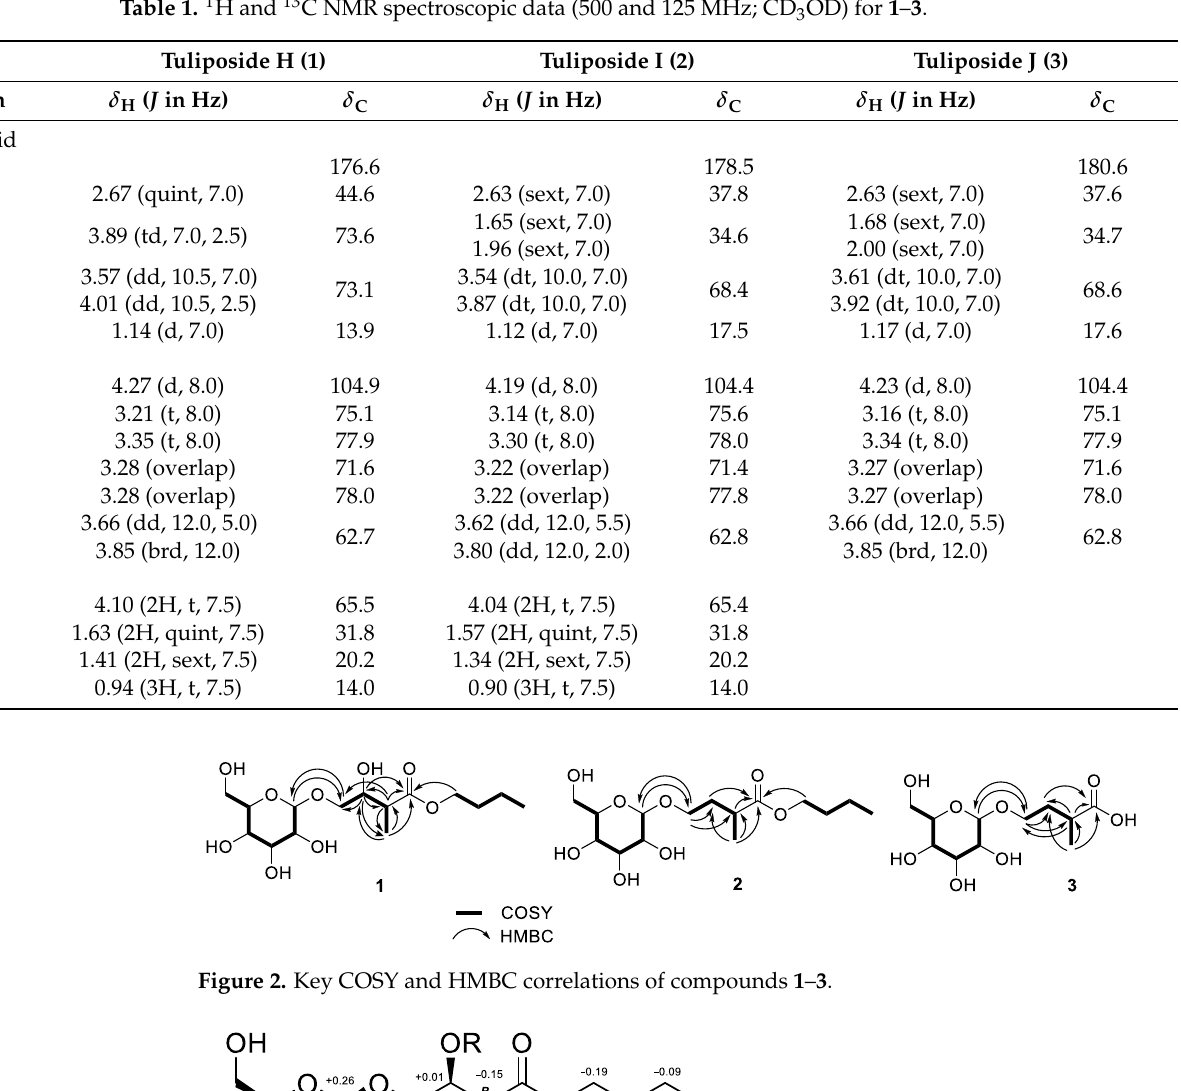
Table 1. 1 H and 13 C NMR spectroscopic data (500 and 125 MHz; CD 3 OD) for 1 – 3 .